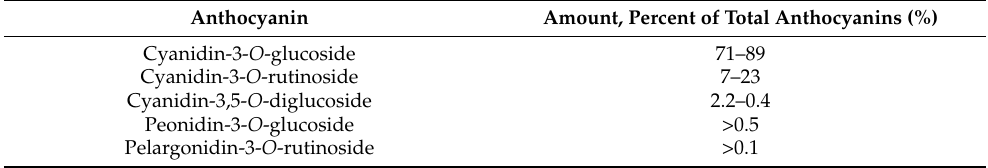
Table 5. Anthocyanin composition of Lonicera caerulea fruits [38,39,76,77].